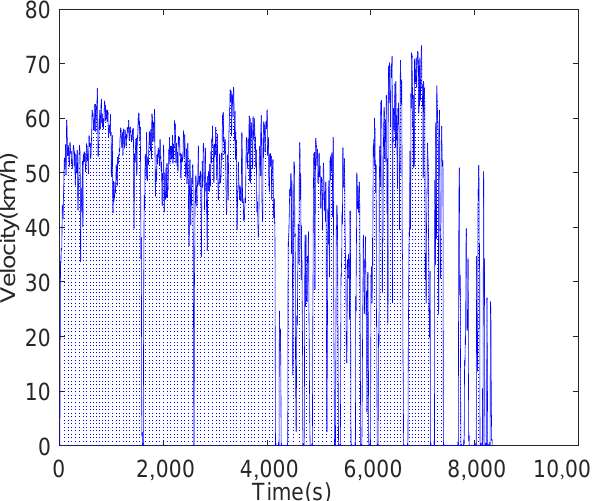
Figure 4. The division of time-velocity sequence in a certain day.